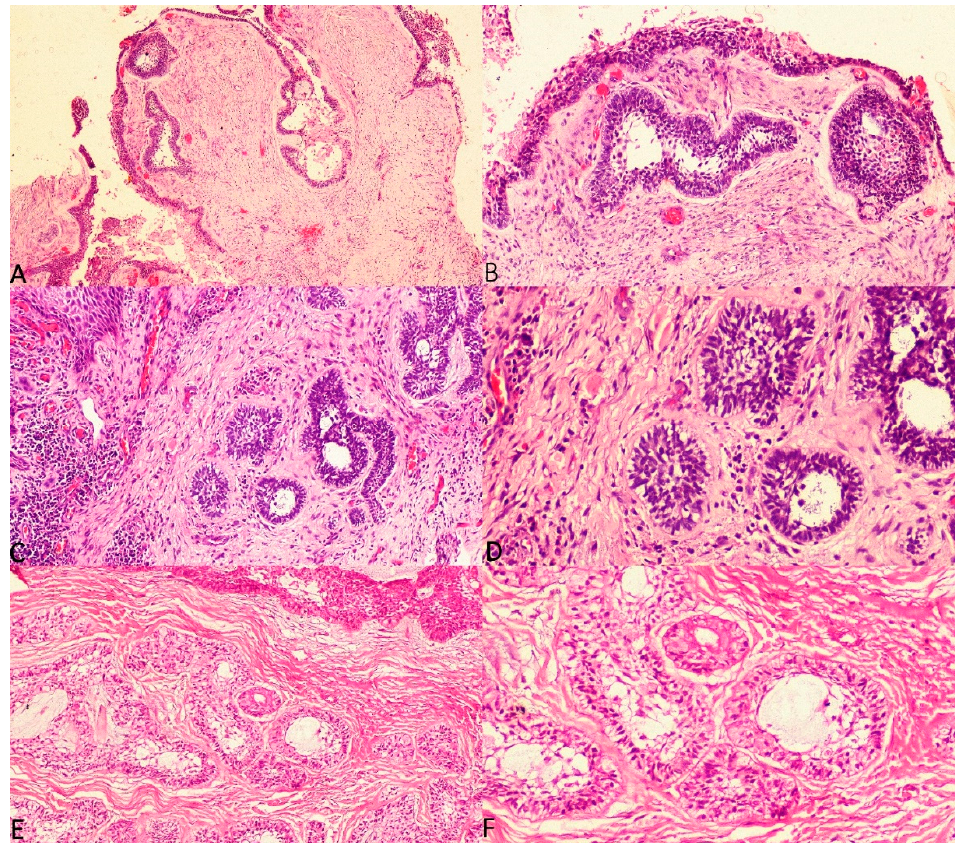
Figure 5. Photomicrographs of haematoxylin and eosin stain. Unicystic ameloblastoma—mural type with mild SOH, ( A ) 40× and ( B ) 100×. Unicystic ameloblastoma—mural type with moderate SOH, ( C ) 100× and ( D ) 200×. Unicystic ameloblastoma—mural type with intense SOH, ( E ) 100× and ( F ) 200×.